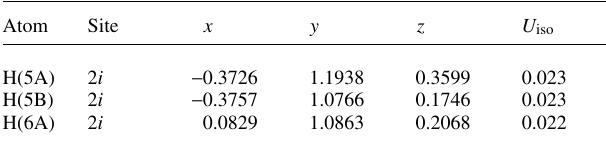
Table 2. Atomic coordinates and displacement parameters (in Å 2 )